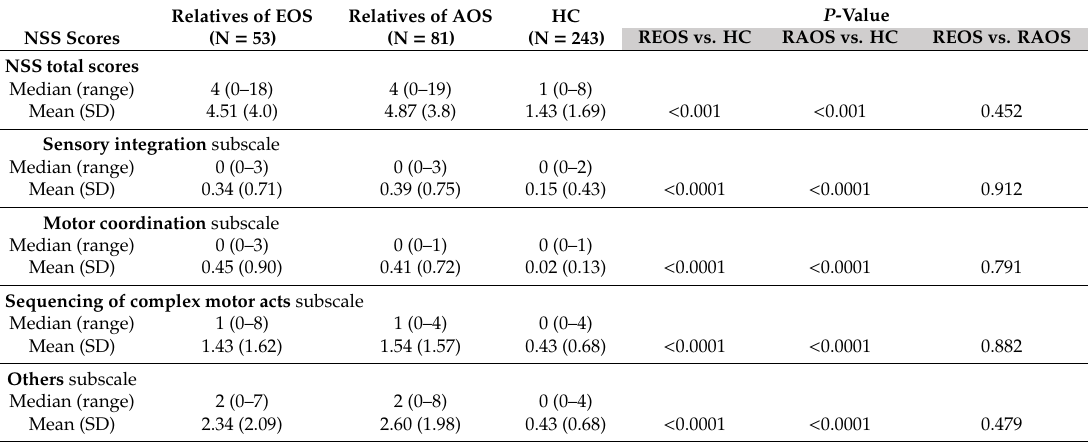
Table 4. Comparison of NSS scores for non-psychotic relatives of early-onset and adult-onset schizophrenia versus healthy controls.